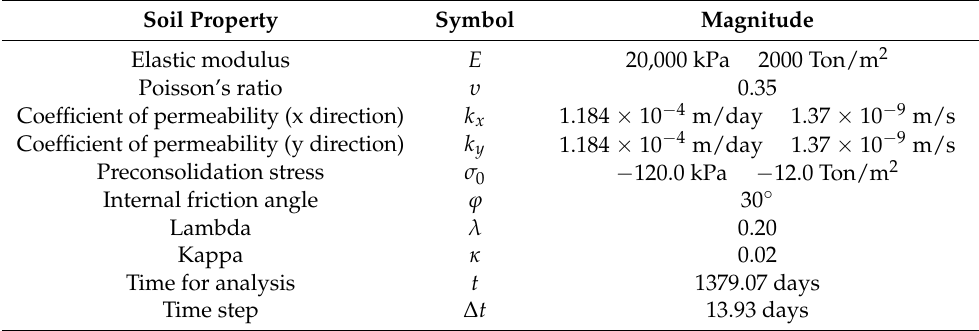
Figure 1. Soil domain under study with triangular linear finite element meshing. Table 1. Properties of the saturated soil for mechanical analysis of the foundation.